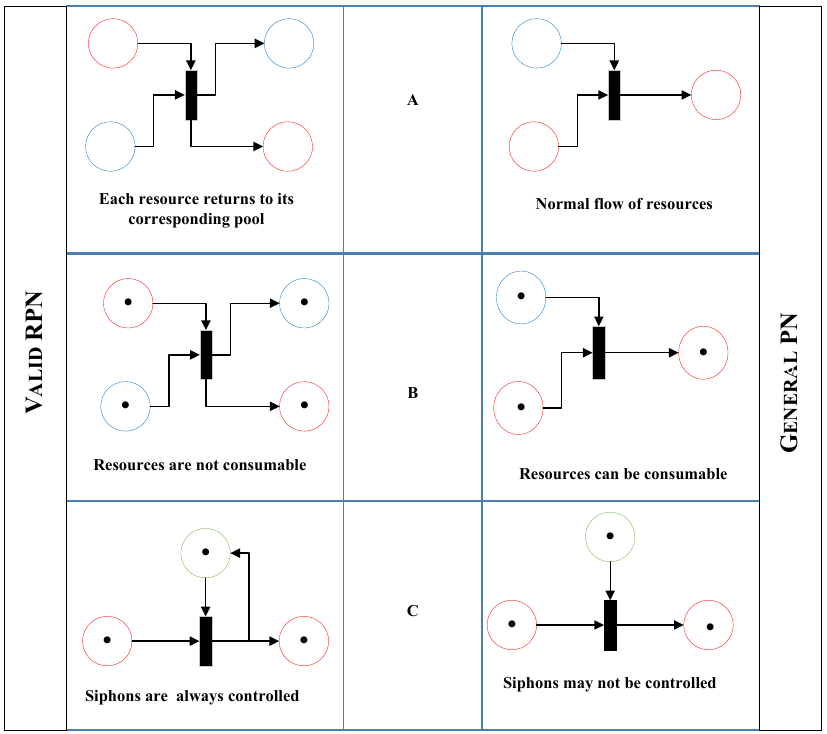
Figure 3. A comparison between RPN architecture (left-hand side) and regular Petri net (right-hand